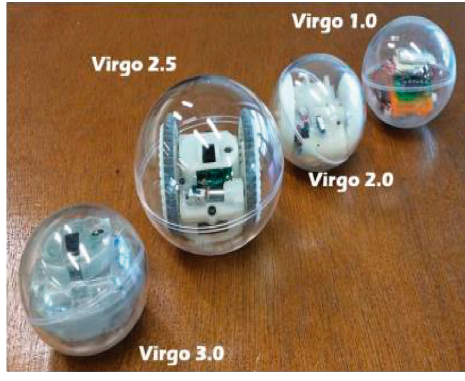
Figure 1: Spherical robot (VIRGO)